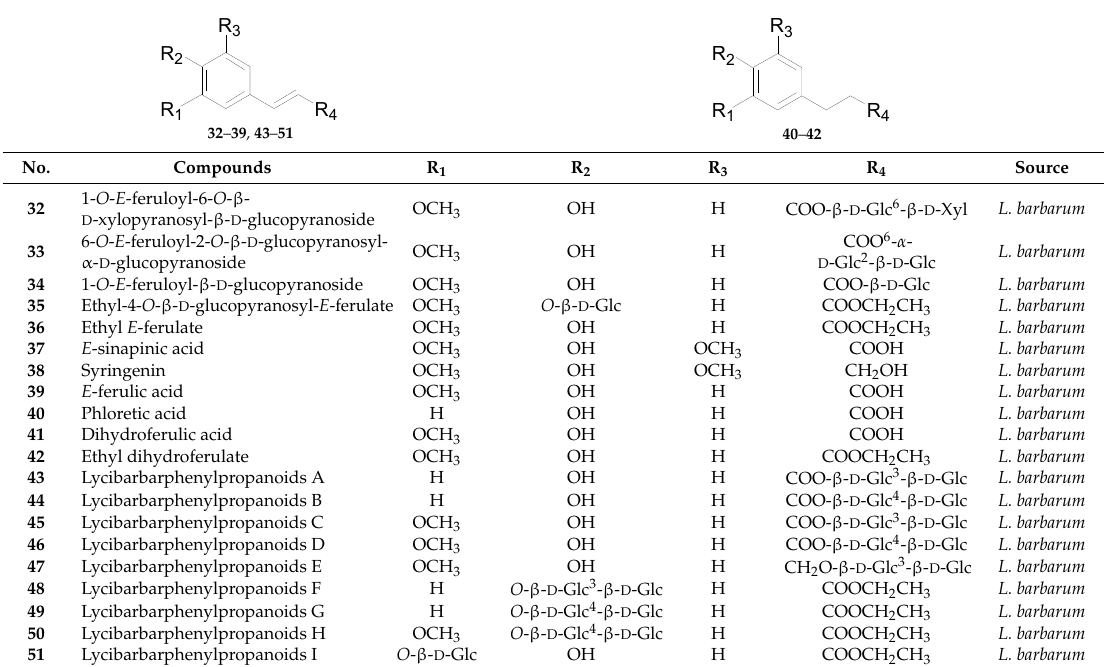
Figure 3. Chemical structures of compounds 23 – 25 , 29 – 31 . Table 4. Chemical structures of compounds 32 – 51 .